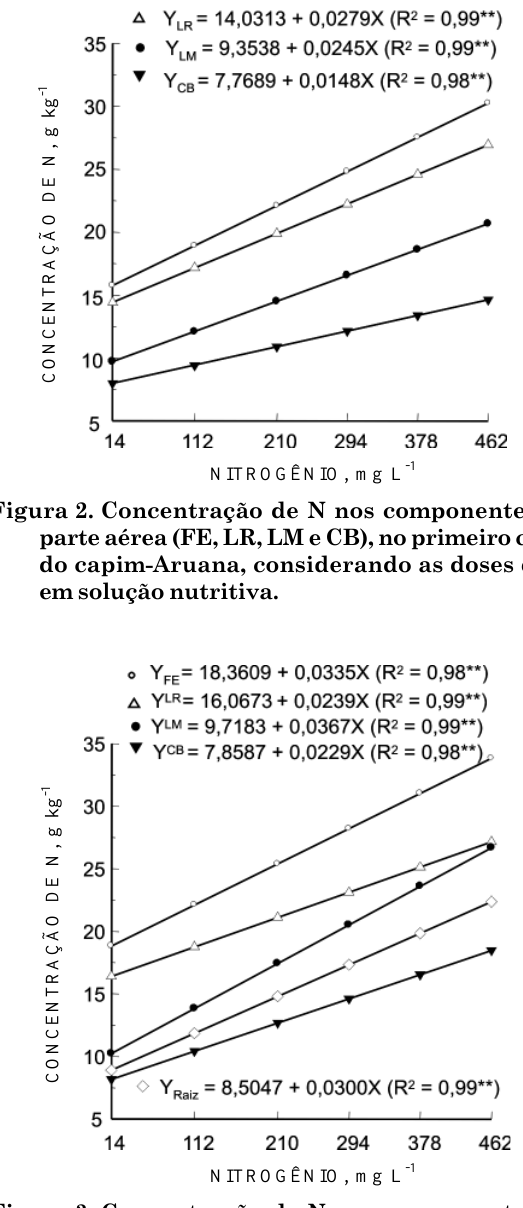
Figura 3. Concentração de N nos componentes da parte aérea (FE, LR, LM e CB) e nas raízes, no segundo corte do capim-Aruana, considerando as doses de N em solução nutritiva.